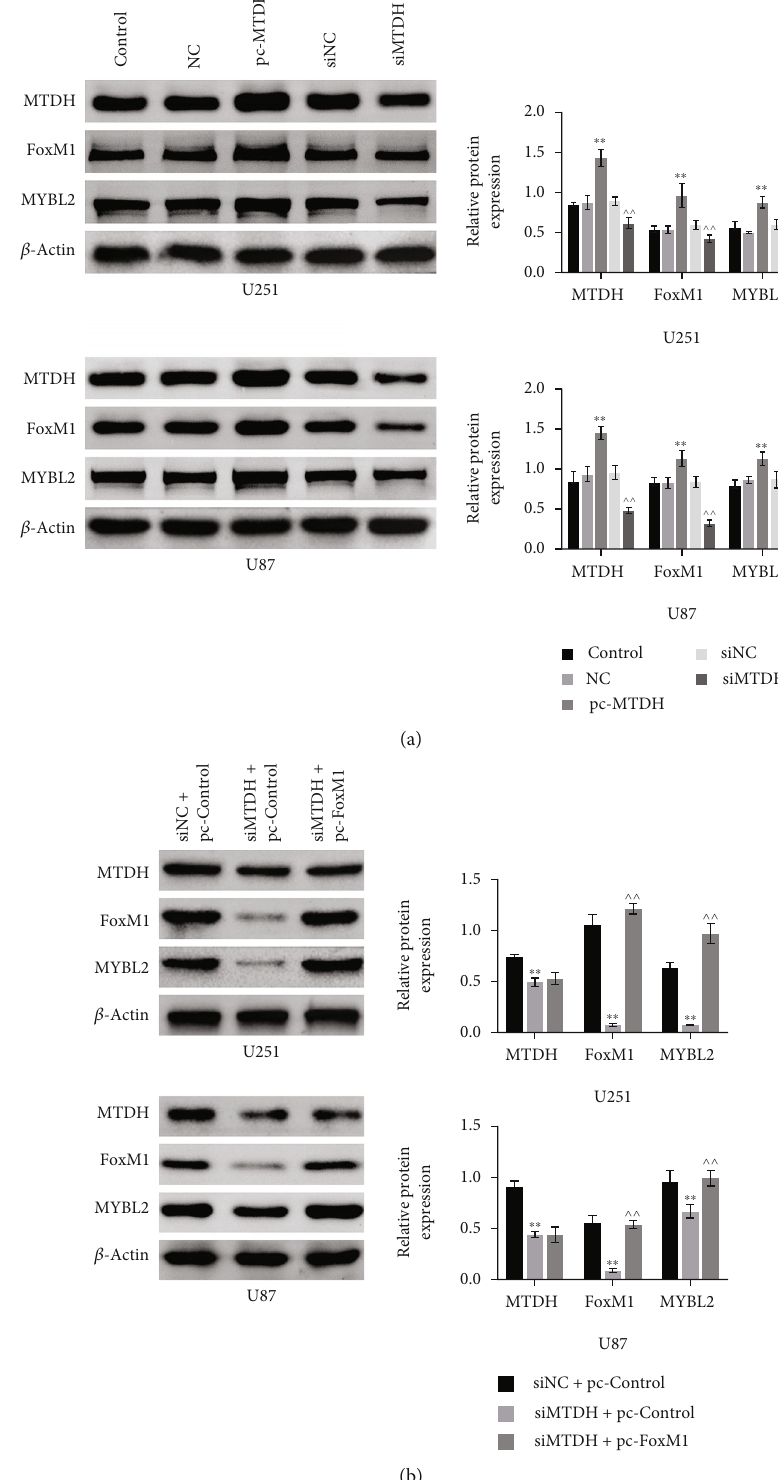
Figure 2: The protein expression of MTDH, MYBL2, and FoxM1 in each group in U251 and U87 cell lines (a). The protein bands of the three genes in the fi ve groups of control, NC, pc-MTDH, and siMTDH and the histogram of the relative protein expression; N = 3 , ∗∗ p < 0 : 01 vs. the NC group; ^^ p < 0 : 01 vs. the siNC group (b). The three genes in siNC+pc-control, siMTDH+. The histogram of protein bands and relative protein expression in the three groups of pc-control and siMTDH+pc-FoxM1. N = 3 , ∗∗ p < 0 : 01 vs. the siNC+pc- control group; ^^ p < 0 : 01 vs. the siMTDH+pc-control